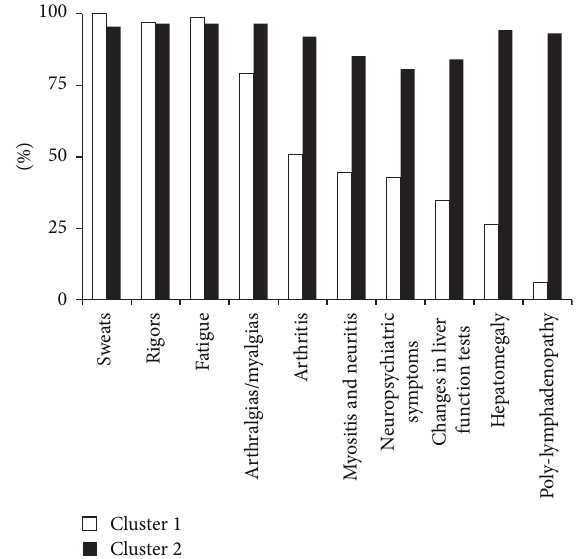
Figure 1: Percentage of symptoms by cluster groups. Note: changes in liver function tests include aminotransferase, aspartate amino- transferase, and gamma-glutamyl transferase; neuropsychiatric symptoms include depression, lack of concentration, and